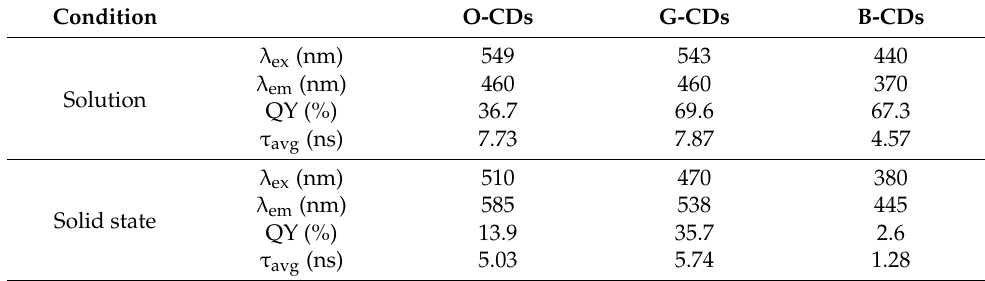
Figure 5. Fluorescence lifetime characterization of O-CDs, G-CDs and B-CDs in ethanol solution ( c = 0.1 mg/mL) ( a ) and in the solid state ( b ).